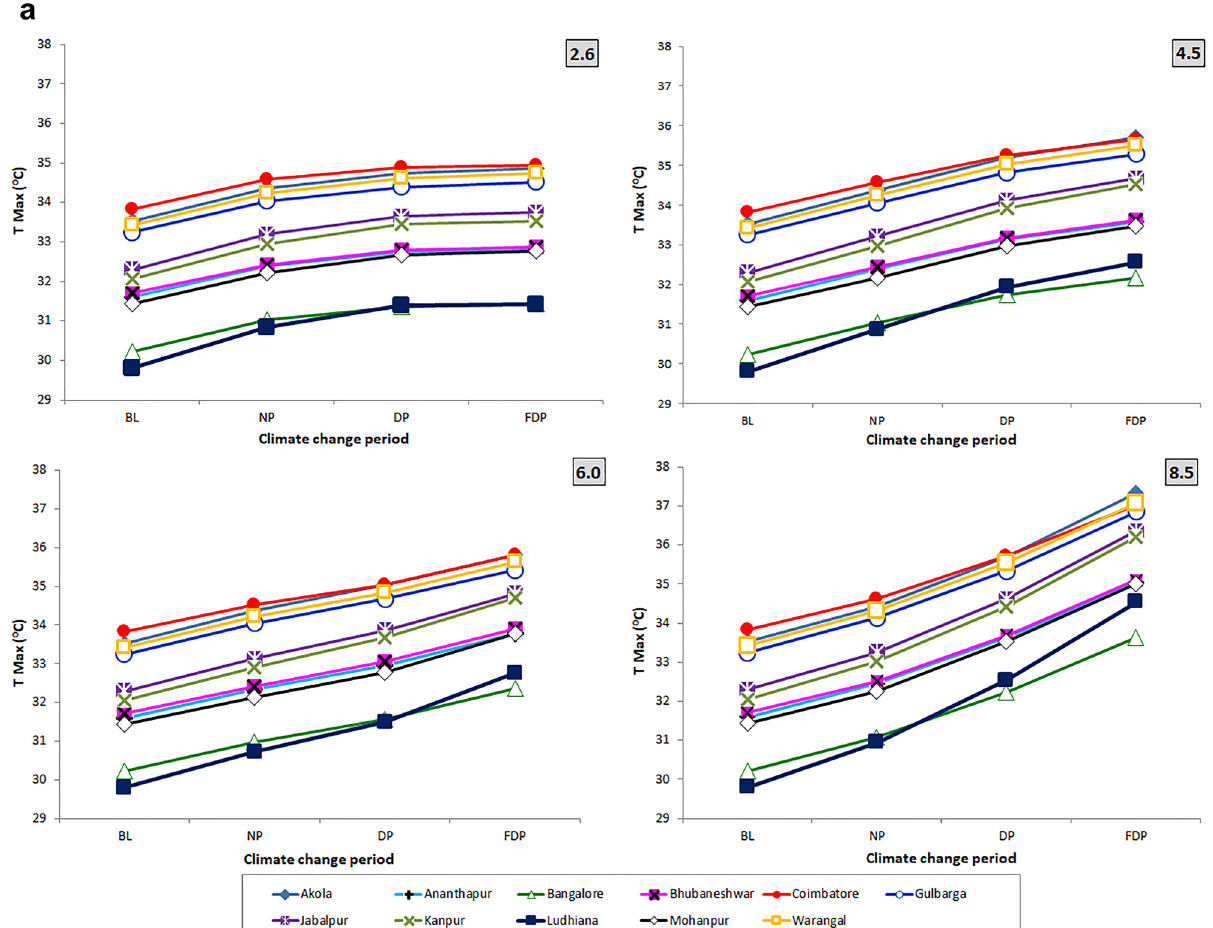
Figure 2. ( a ) Variation of Tmax during CCPs in 4 RCPs across different locations of India. ( b ) Variation of Tmin during CCPs in 4 RCPs across different locations of